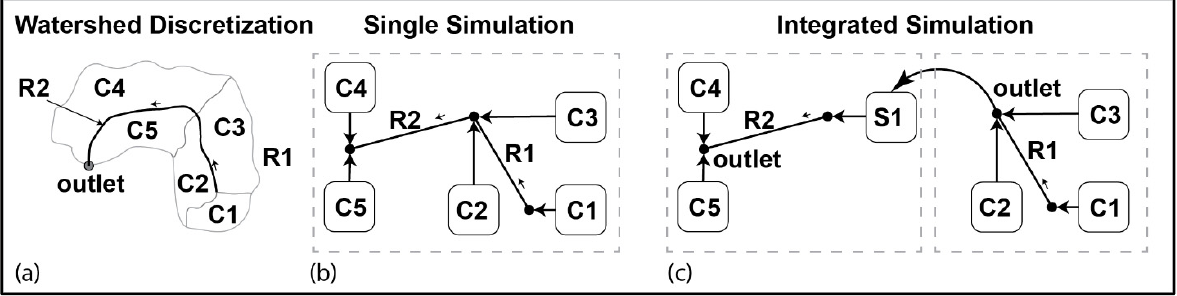
Figure 1. Schematic representation of watershed as basic modeling units: AnnAGNPS cells (sub-catchments) and reaches (concentrated flow). Geographic Information Systems analysis based on topographic information is often used to discretize the watershed into cells and reaches ( a ). Internally, the discretized watershed is represented by a hierarchical network ( b ). Enhancements to the AnnAGNPS model include capabilities for manual or automated linking of independent simulations, in which a new model unit, the external source cell, is defined (S1 in c ).